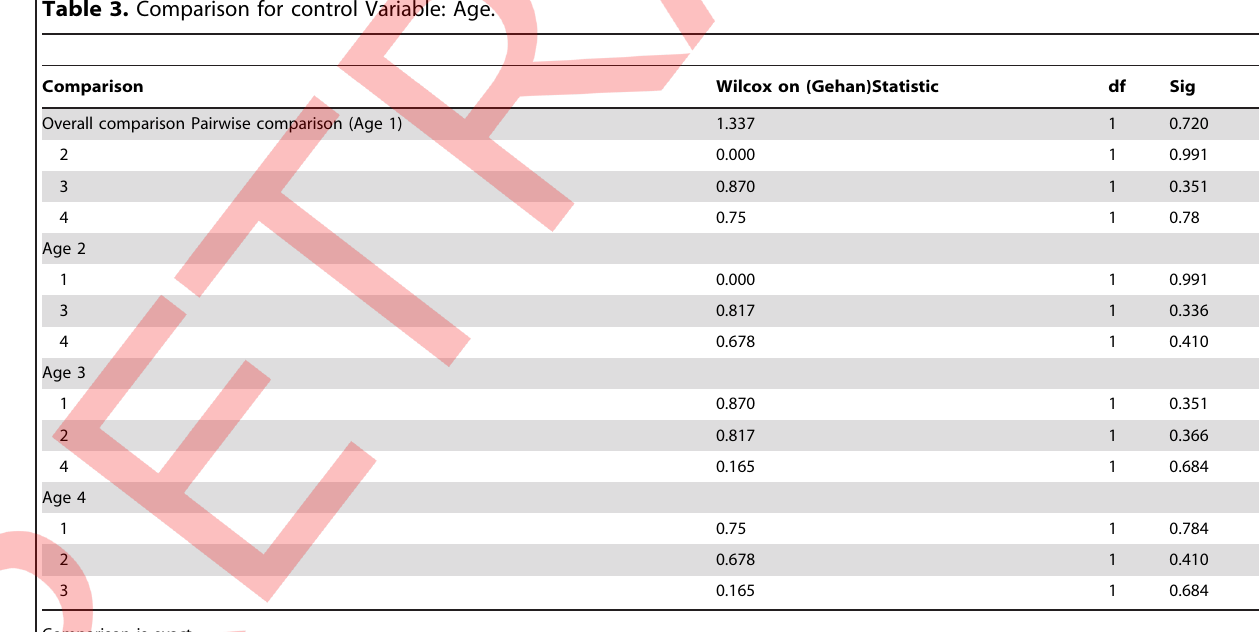
Table 3. Comparison for control Variable: